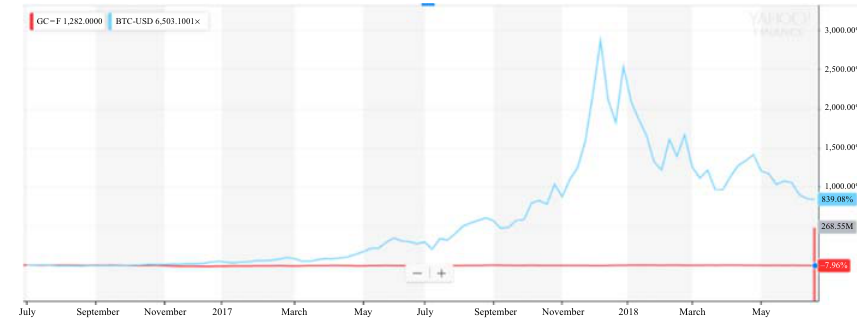
Figure 3. Price volatility comparison between gold and